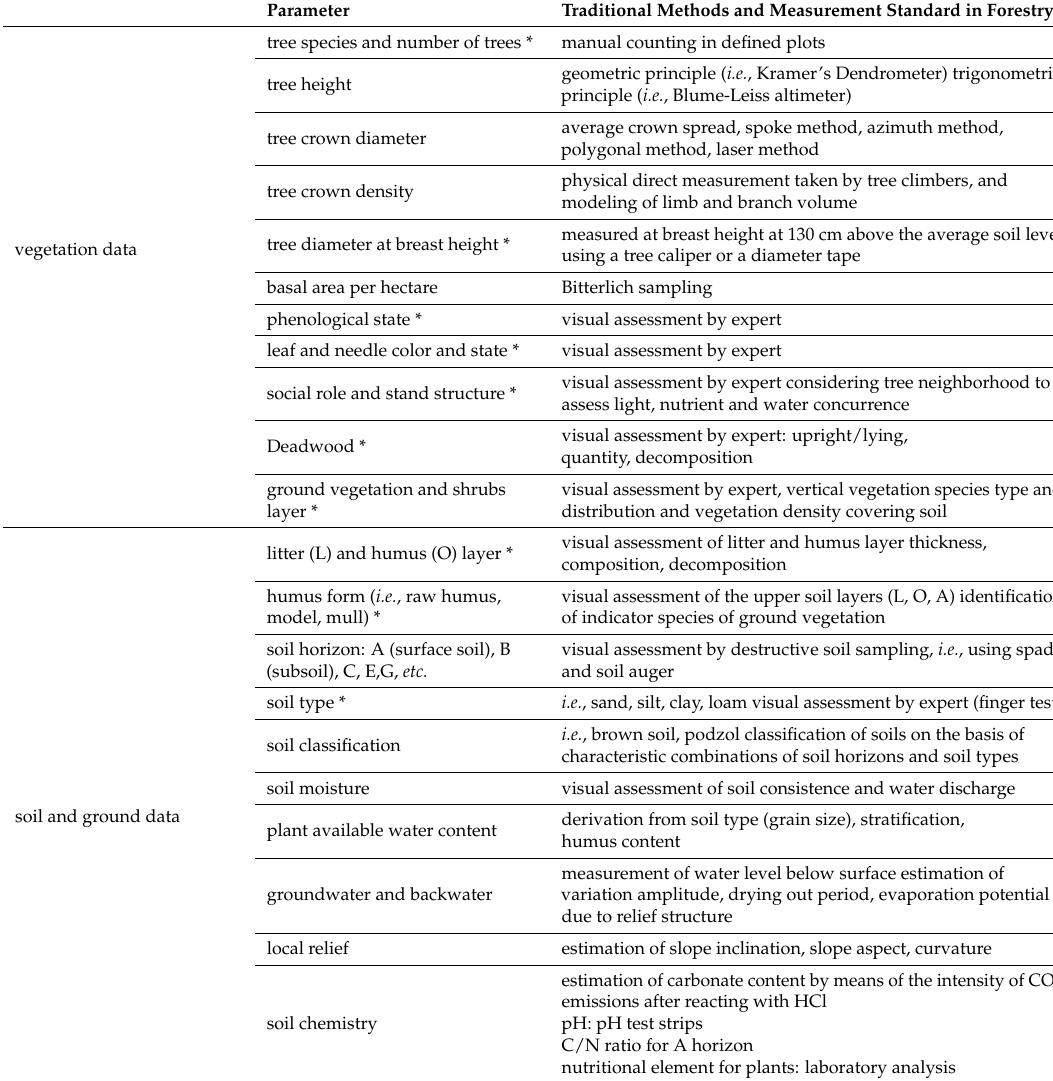
Table 2. Summary of key forest and stand tree parameters observed in different forest inventories. (* generally sampled for forest